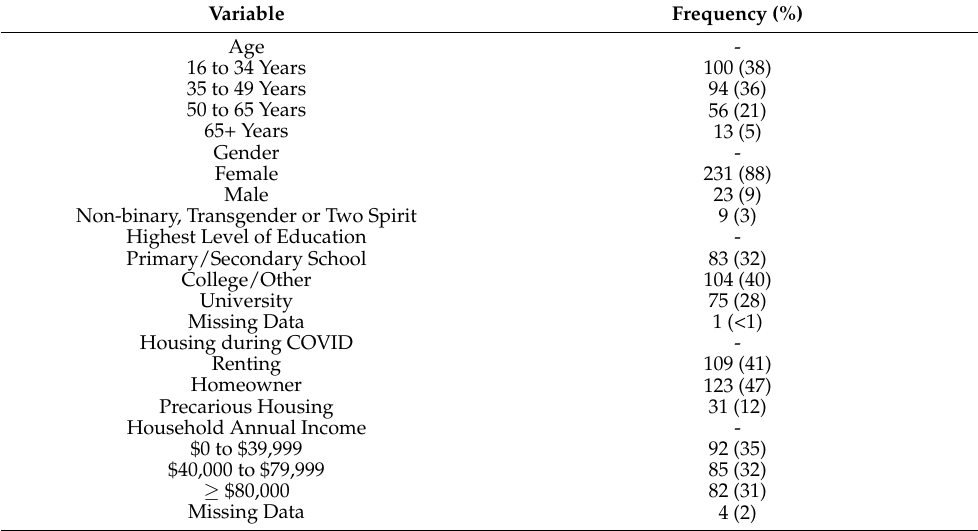
Table 1. Participant demographic characteristics ( n = 263).